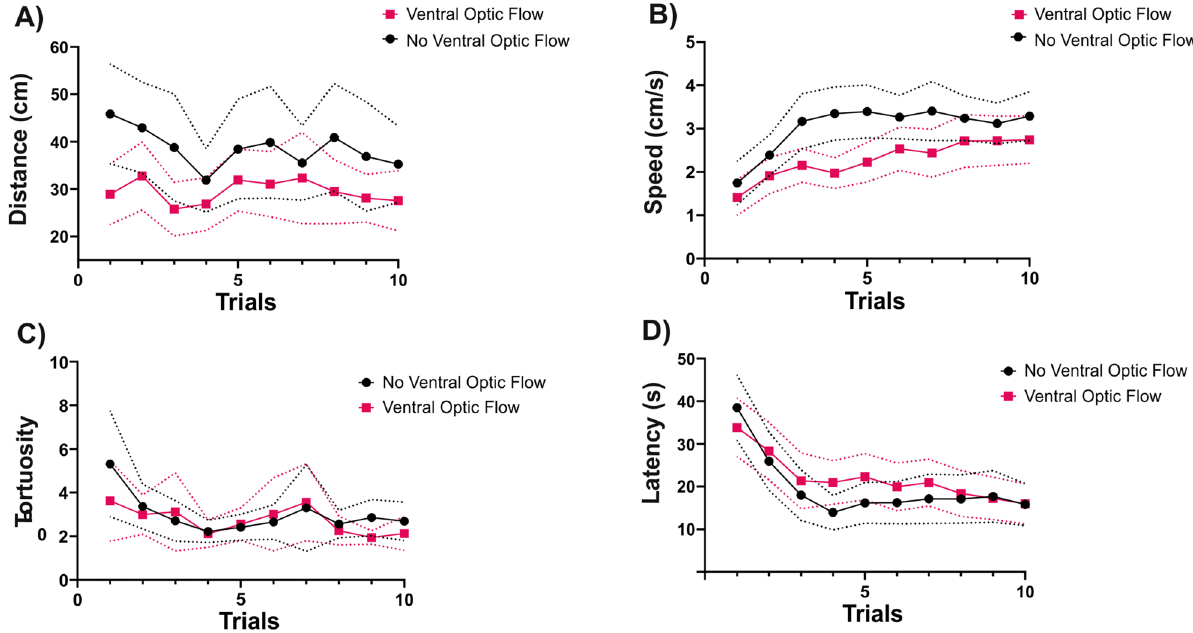
Figure 8. Motor and temporal components of bee trajectories during the acquisition trials. For each ventral optic-flow condition, the evolution of ( A ) the distance walked, ( B ) the walking speed, ( C ) the tortuosity and ( D ) the choice latency during training trials is shown. The tortuosity was the ratio between the total distance walked and the straight line connecting the first and the last point of the trajectory during a training trial. ‘ Ventral Optic Flow’ (N = 38), ‘ No Ventral Optic Flow ’ (N = 29). The dashed lines above and below the curves represent the 95% confidence